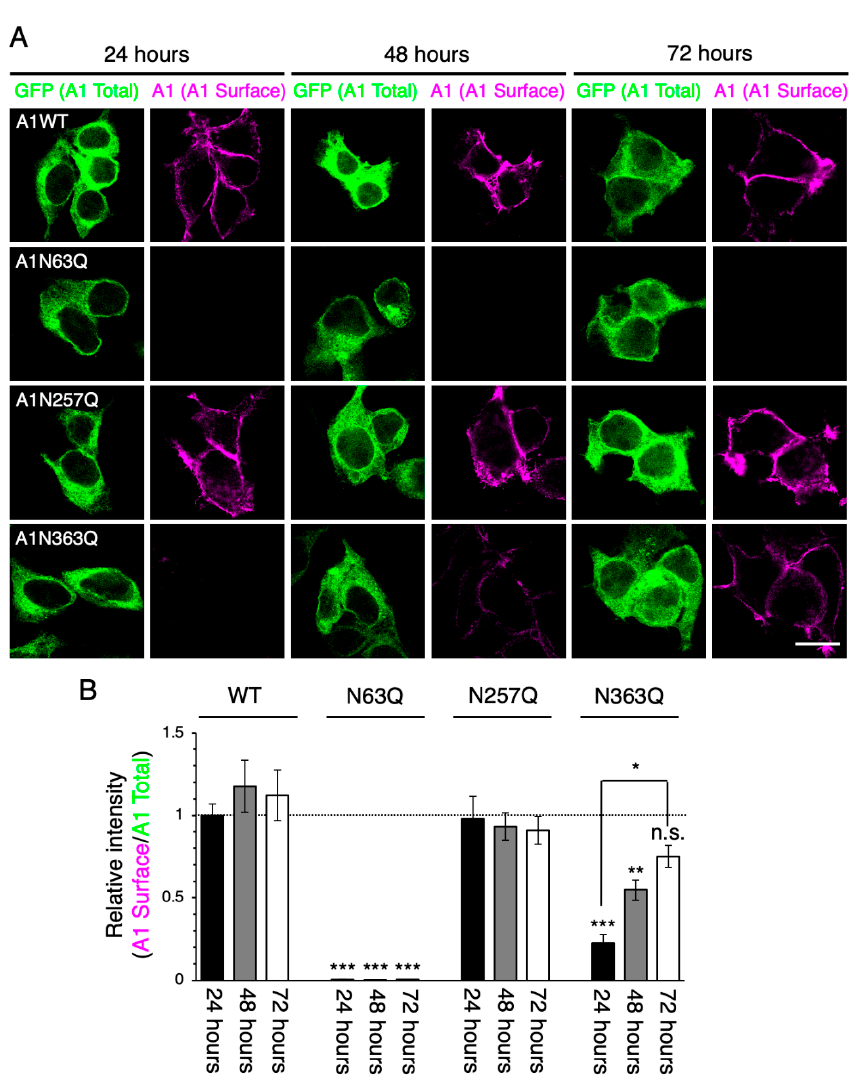
Figure 1. Cell surface expression levels of GluA1N363Q increase in a time-dependent manner. ( A ) Representative immunostaining images showing the cell surface expression levels of wild-type (WT) and mutant (N63Q, N257Q, and N363Q) GluA1. HEK293 cells were stained using an anti-GluA1 mAb (magenta; pseudocolor). The fluorescence intensity of green fluorescent protein (GFP; shown in green) indicates the total expression levels of individual GluA1 subunits. Scale bar, 20 µm. ( B ) Relative intensities of cell surface GluA1 WT and mutants at 24, 48, and 72 h post-transfection. The fluorescence intensity of surface GluA1 was normalized to that of GFP and GluA1WT at 24 h post-transfection. ***, p < 0.001; **, p < 0.01; *, p < 0.05; n.s., p > 0.05. Error bars represent the standard error of the mean